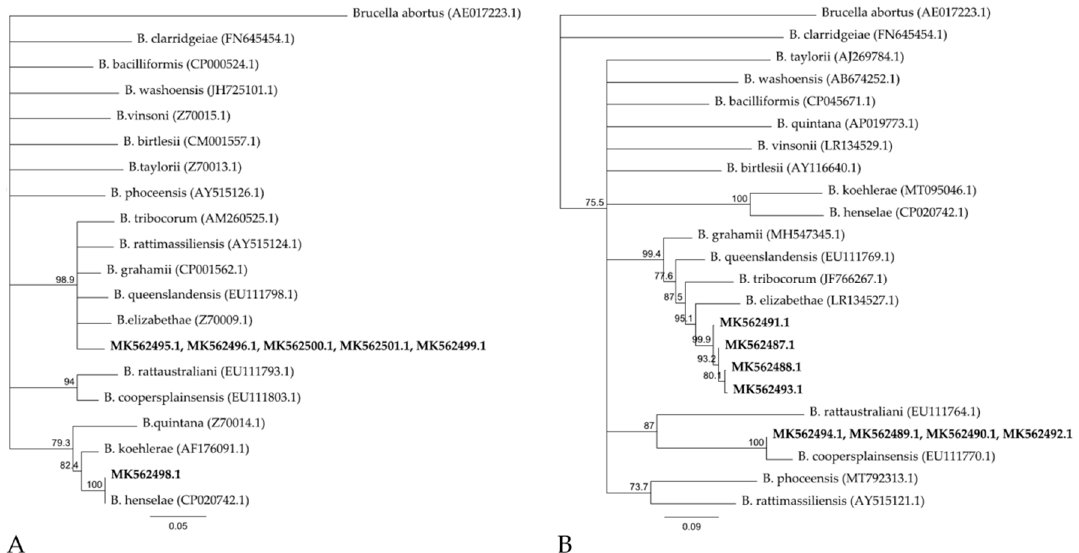
Figure 1. Phylogenetic trees based on the gltA (340 bp) ( A ) and ITS (512 bp) ( B ) partial sequences of Bartonella identified in the present study (GenBank accession number in bold) and from GenBank (description and GenBank accession number in bracket). The phylogenetic tree was constructed selecting Tamura-Nei as genetic distance and Neighbor-Joining as tree building method. Bootstrap calculation was carried out with 1000 resamplings with support threshold ≥ 70%. Phylogenetic trees were built using Geneious Prime software version 2019.0.4.